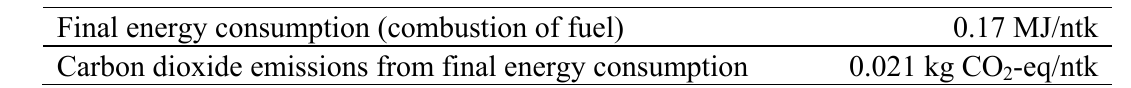
Table 2. Emissions and energy use factors per net tonne-kilometer (ntk) for international shipping (as per [5]).